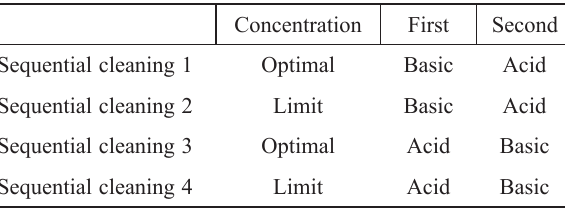
Table 2 – Combination of cleaning agents at optimal and limit concentrations in sequential cleanings Concentration